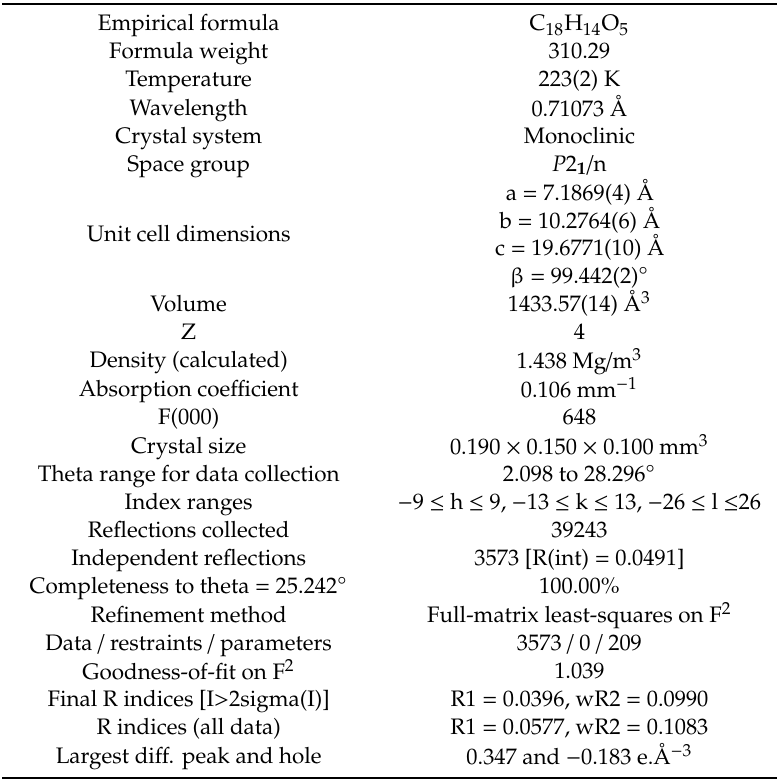
Table 1. Crystal data and structure refinement for Compound 6